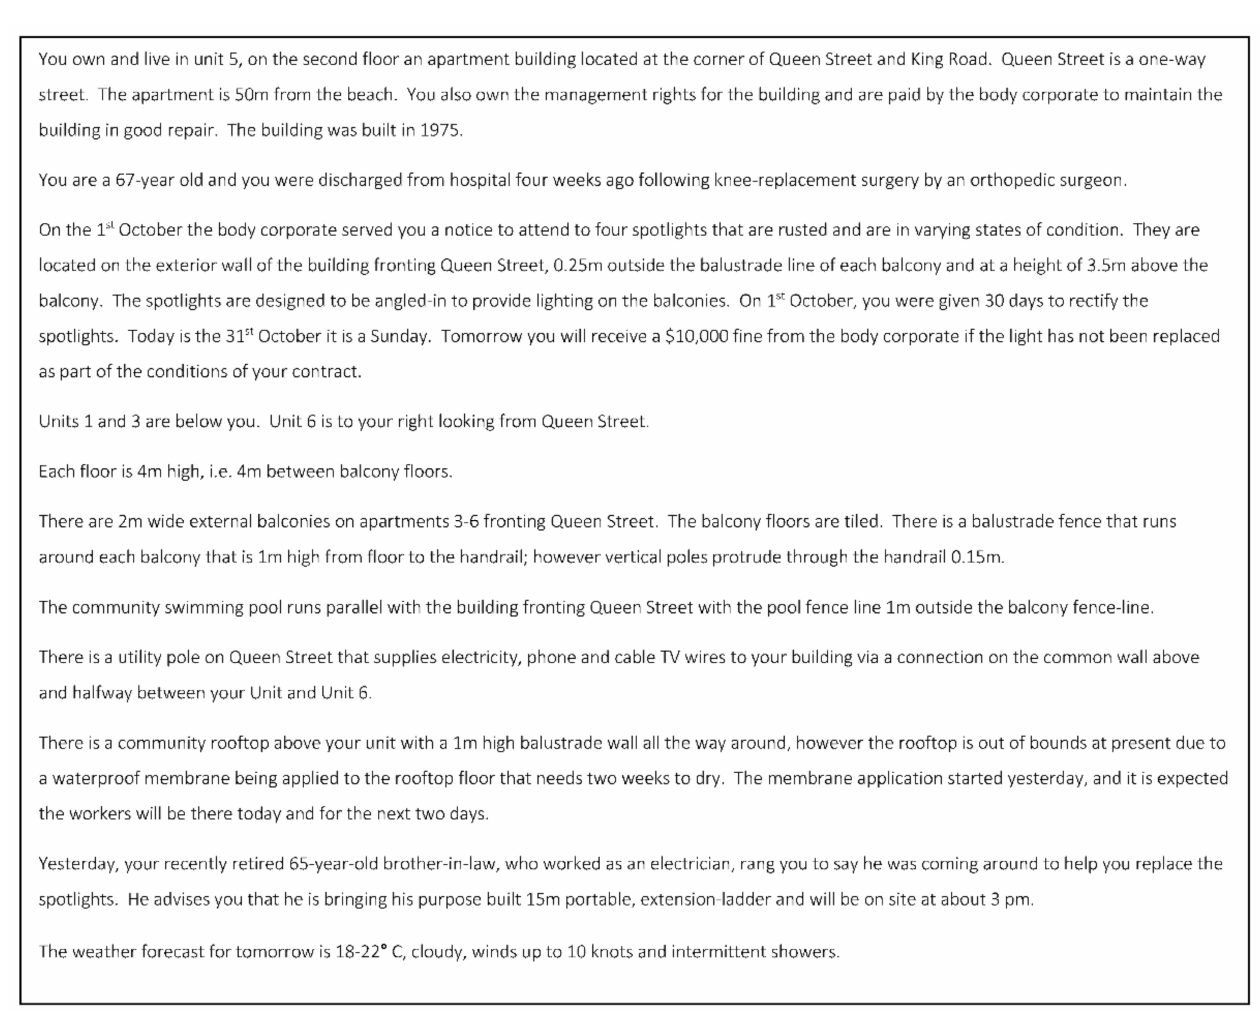
Figure 1. The risk scenario